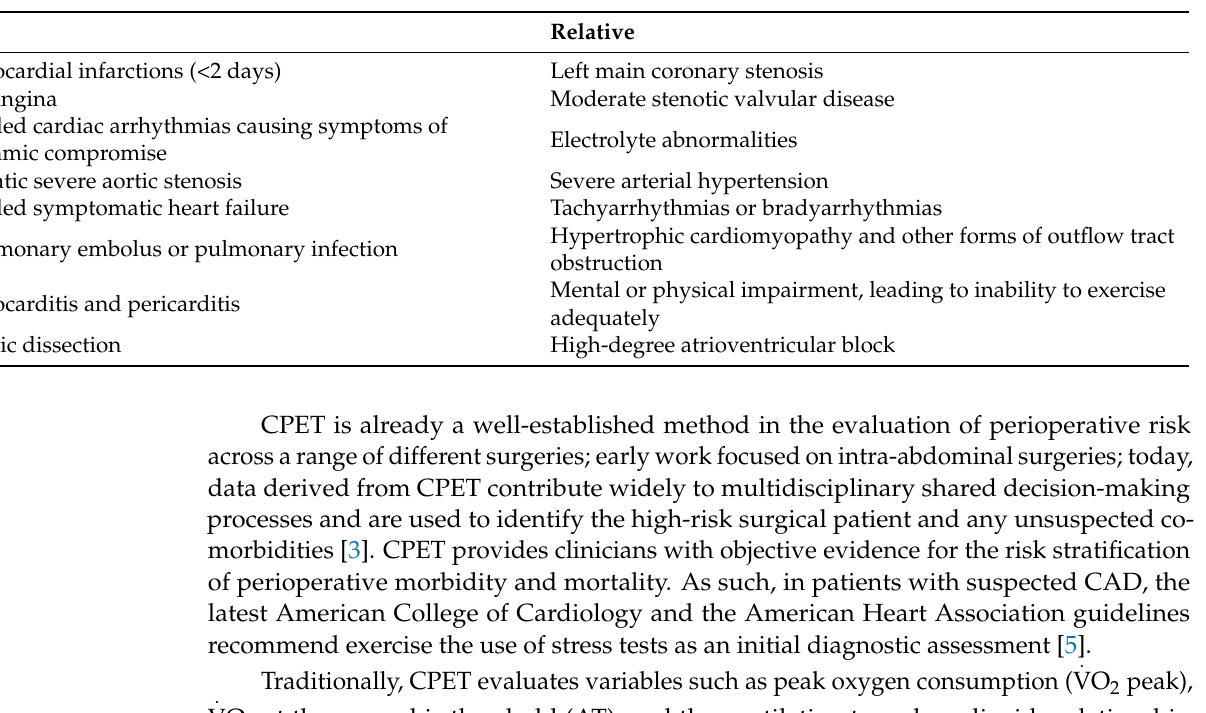
Table 1. List of absolute and relative contraindications (Adapted with permission from [4]. 1997, American Heart